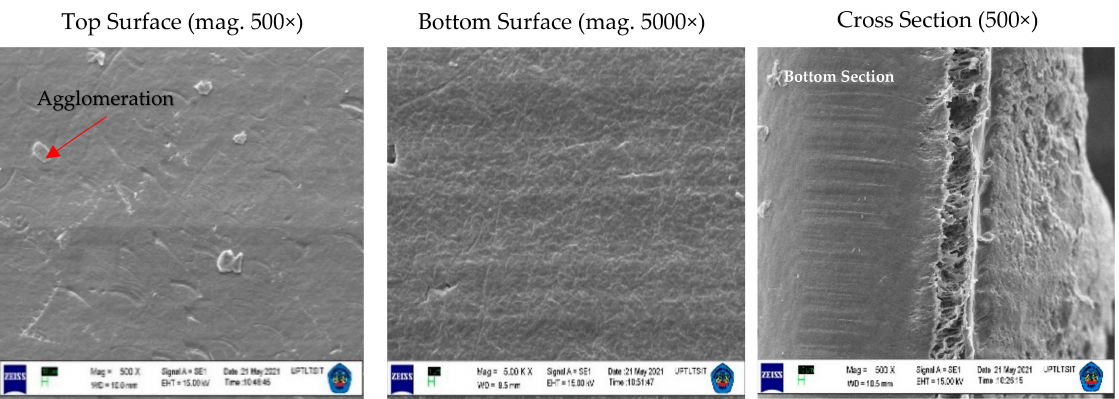
Figure 4. Structure of the PVDF and tin dioxide membrane for 15 wt% PVDF with 1% tin dioxide. Top Section with Magnitude = 500 × , WD = 10.5 mm, EHT = 15.00 kV, Signal A = SE1. Bottom Section with Magnitude = 5.00 K × , Working Distance (WD) = 10.5 mm, EHT = 15.00 kV, Signal A = SE1. Cross Section with Magnitude = 500 × , WD = 10.0 mm, EHT = 15.00 kV, Signal = SE1.